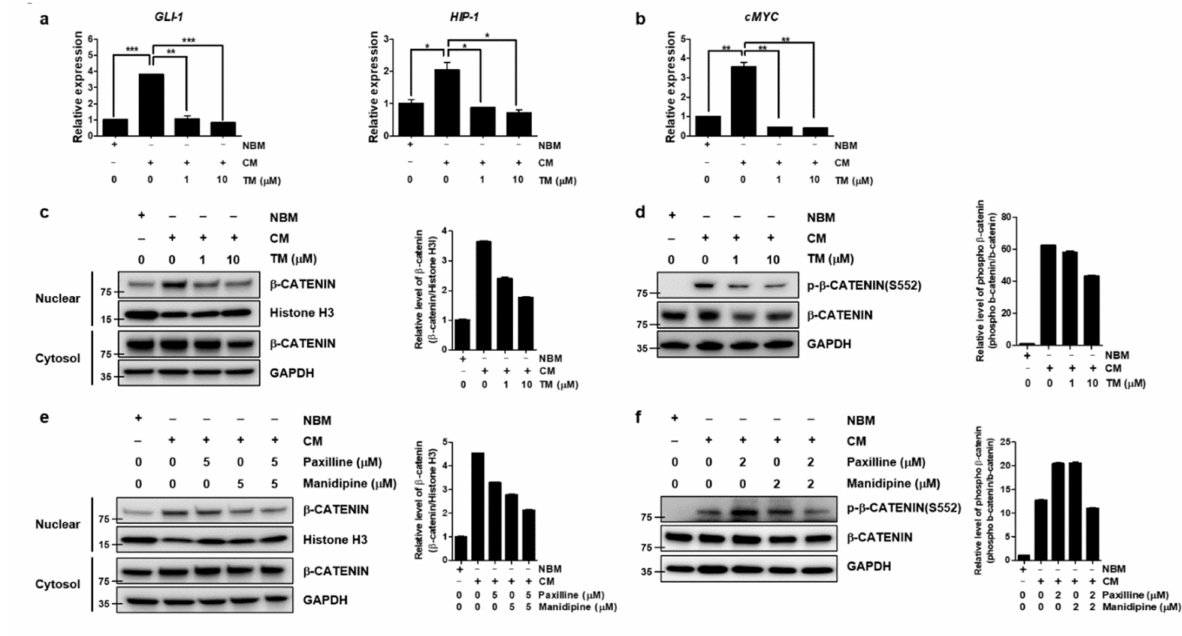
Figure 4. TM further reduces Wnt/ β -catenin signaling by simultaneously inhibiting the BKCa and calcium channels in ovarian CSCs. After TM was applied to CSC culture of A2780-SP cells for 24 h, ( a ) relative mRNA expression change of GLI-1, HIP1 and PTCH-1 for HH pathway, and ( b ) relative mRNA expression change of c-Myc for Notch pathway were analyzed. The data are expressed as the mean ± SD of two or three independent experiments. * p < 0.05, ** p < 0.01, *** p < 0.001. ( c ) TM was applied to CSC culture of A2780-SP cells for 24 h and the reduced translocation of β -catenin into the nucleus by TM was analyzed by Western blot. Histone H3 and GAPDH were used as loading controls for the nuclear and cytosol fractions, respectively. ( d ) Reduced β -catenin phosphorylation at S552 by TM on CSC culture of A2780-SP cells was analyzed by Western blot. GAPDH was used as a loading control for cell lysates. ( e ) The BKCa and calcium channels were simultaneously inhibited by cotreatment with 5 µ M of paxilline and 5 µ M of manidipine for 24 h in CSC culture of A2780-SP cells, compared to individual treatments. β -catenin translocation into the nucleus was analyzed by Western blot. ( f ) The BKCa and calcium channels were simultaneously inhibited by cotreatment with 2 µ M of paxilline and 2 µ M of manidipine for 24 h on CSC culture of A2780-SP cells, compared to individual treatments. Reduced β -catenin phosphorylation at S552 by simultaneous inhibition of the BKCa and calcium channels was analyzed by Western